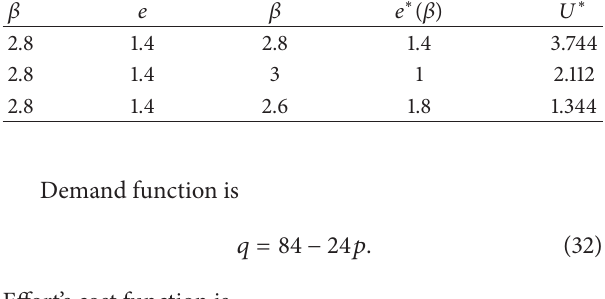
̂𝛽 is announced by